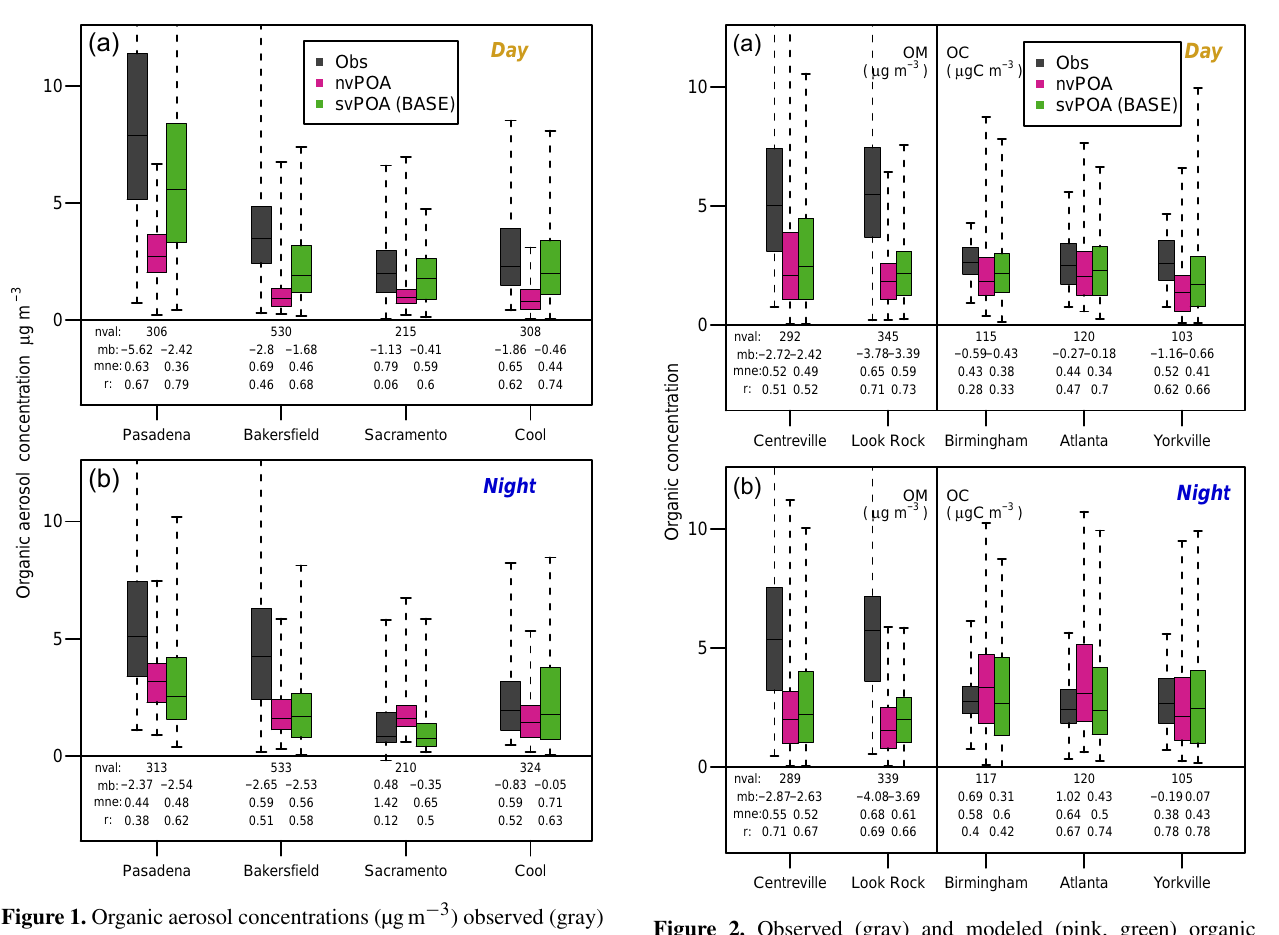
Figure 2. Observed (gray) and modeled (pink, green) organic aerosol (µgm − 3 ) and organic carbon (µgCm − 3 ) concentrations at sites in the southeast US. OA concentrations at the SOAS sites, Cen- treville and Look Rock, were measured with HR-ToF-AMS, while OC concentrations at the SEARCH sites, Birmingham, Atlanta, and Yorkville were inferred as the difference between total car- bon measured by ambient particulate carbon monitors and elemen- tal carbon measured by aethalometers. Also shown are the model- predicted distributions at each site using the nonvolatile (pink) and base-case semivolatile (green) configurations. The boxes denote the 25th and 75th percentiles of each dataset, while the whiskers ex- tend to the most extreme points. (a) and (b) show data for daytime (08:00–20:00) and nighttime hours, respectively. Model values for the SOAS sites are projected to PM 1 to correspond roughly to the size cutoff of the AMS, while for the SEARCH sites the sum of the Aitken and accumulation modes was applied. All model data are produced from the EUS simulation, which uses SAPRC07tic and occurs during June